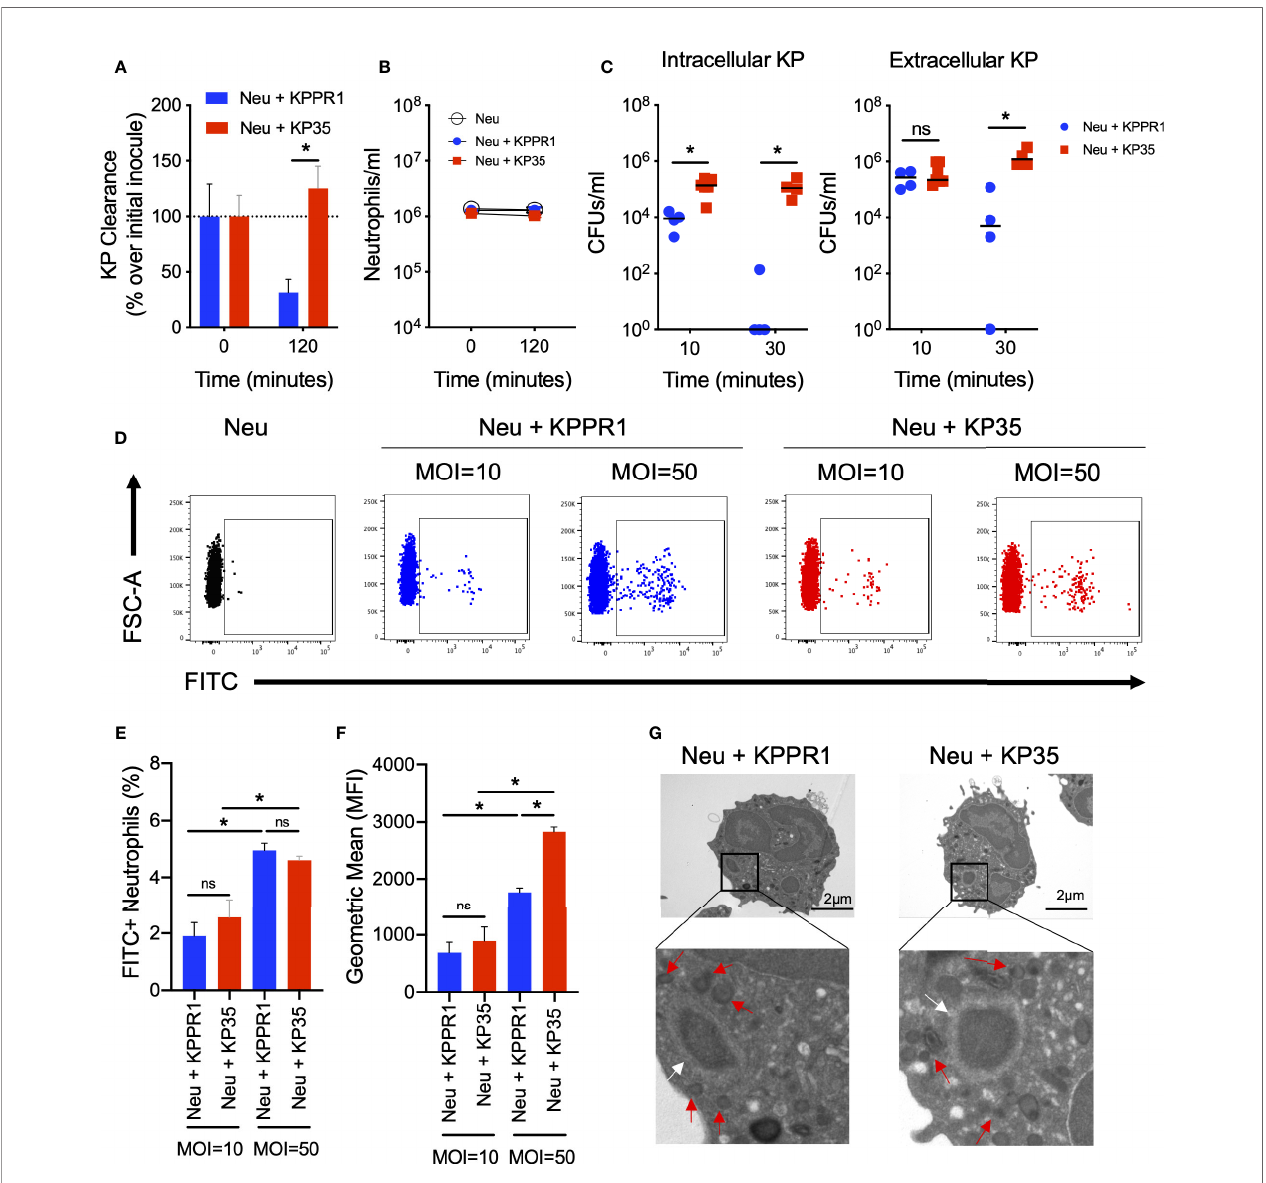
FIGURE 1 | KP35 evades neutrophil killing but does not prevent phagocytosis. (A) KP35 and KPPR1 killing (MOI = 1) and (B) neutrophil count were evaluated for 2h. (C) Neutrophil phagocytosis of KP35 and KPPR1 (MOI = 1) were quanti fi ed by differential centrifugation in LB agar plates after 10 and 30 min. (D – F) These results were con fi rmed by fl ow cytometry (MOIs = 10 and 50) after 10 min. (G) KPPR1-phagosome and KP35-phagosome were visualized by TEM after 30 min (white arrows) and granules surrounding the phagosome (red arrows) were identi fi ed from the pictures obtained. (A – C) , *P < 0.05, for single comparisons (t-test). (D – F) , *P < 0.05, for multiple comparisons, one-way ANOVA test followed by a Tukey ’ s multiple test comparison. ns, non signi fi